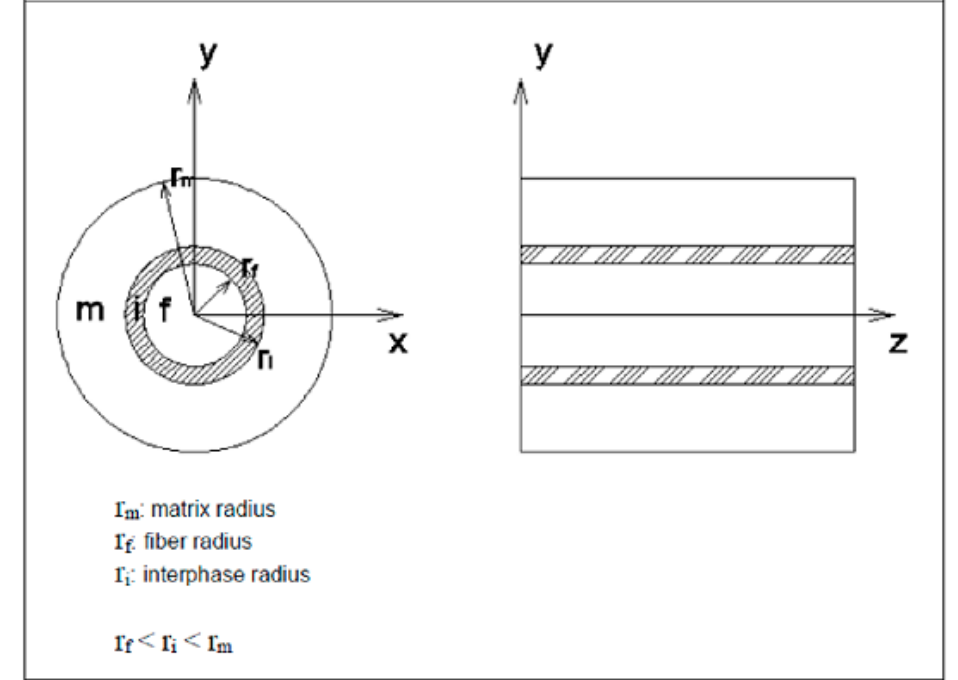
Figure 1. Cross-sectional area and the three phase cylinder